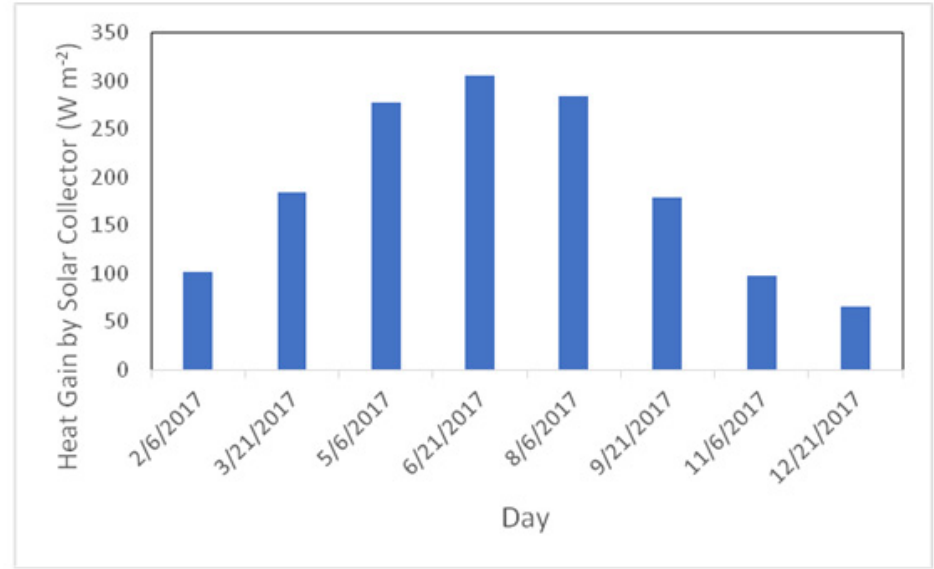
Figure 13. Heat gained by solar collector during different days over the year.